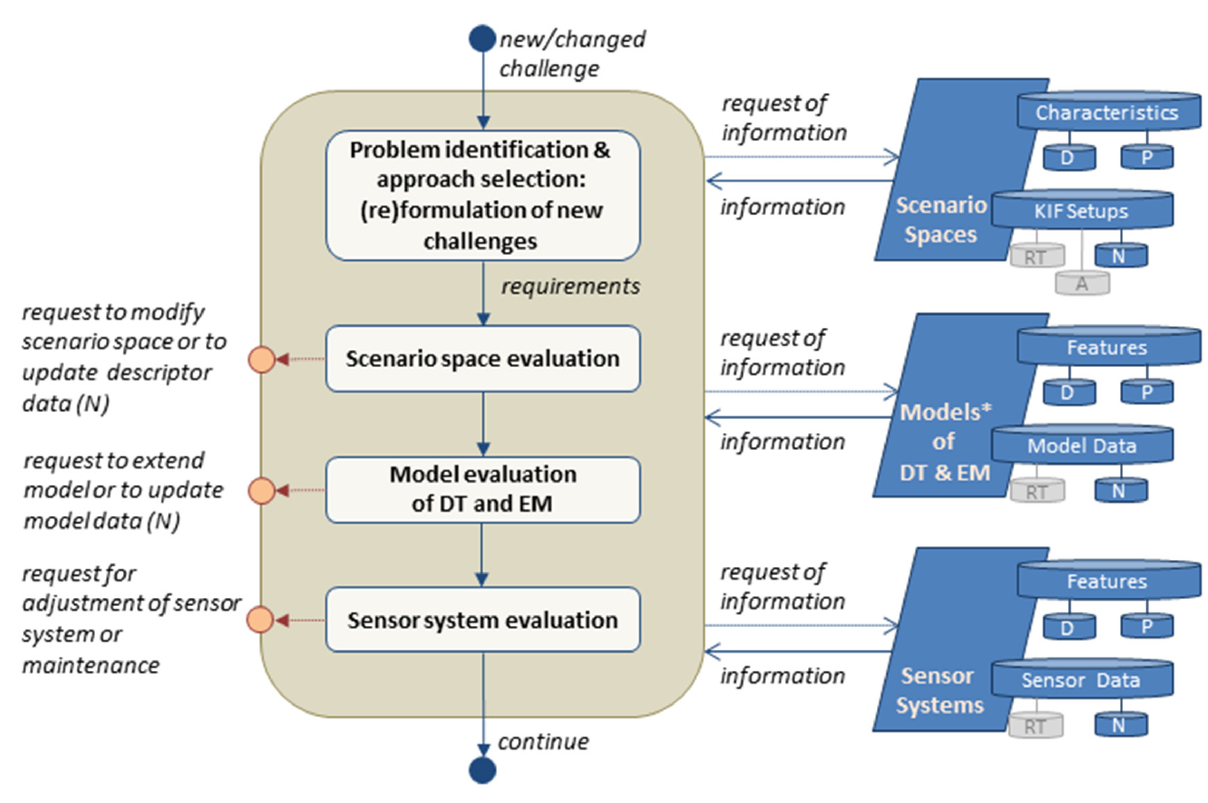
Figure 3. Flow chart of context specification as initial task of the resilience management process.